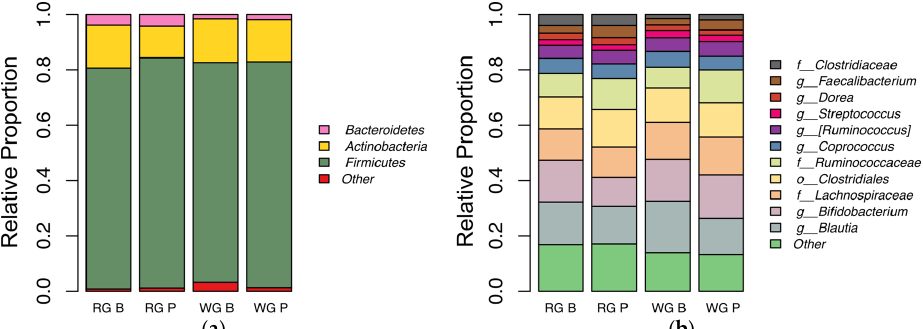
Figure 6. Relative proportion of taxa in each experimental group. The relative proportion of taxa at baseline (B) and post intervention (P) for the refined grain (RG) and whole (WG) treatments: ( a ) the relative proportion of bacteria at the phylum level; and ( b ) the relative abundance of bacteria at the most specific level of classification available. In both panels, taxa present at a median of 1% relative abundance in the data set are shown. Taxa present at lower than 1% median relative abundance are grouped into the “Other” category. Nutrients 2017 , 9 , 173